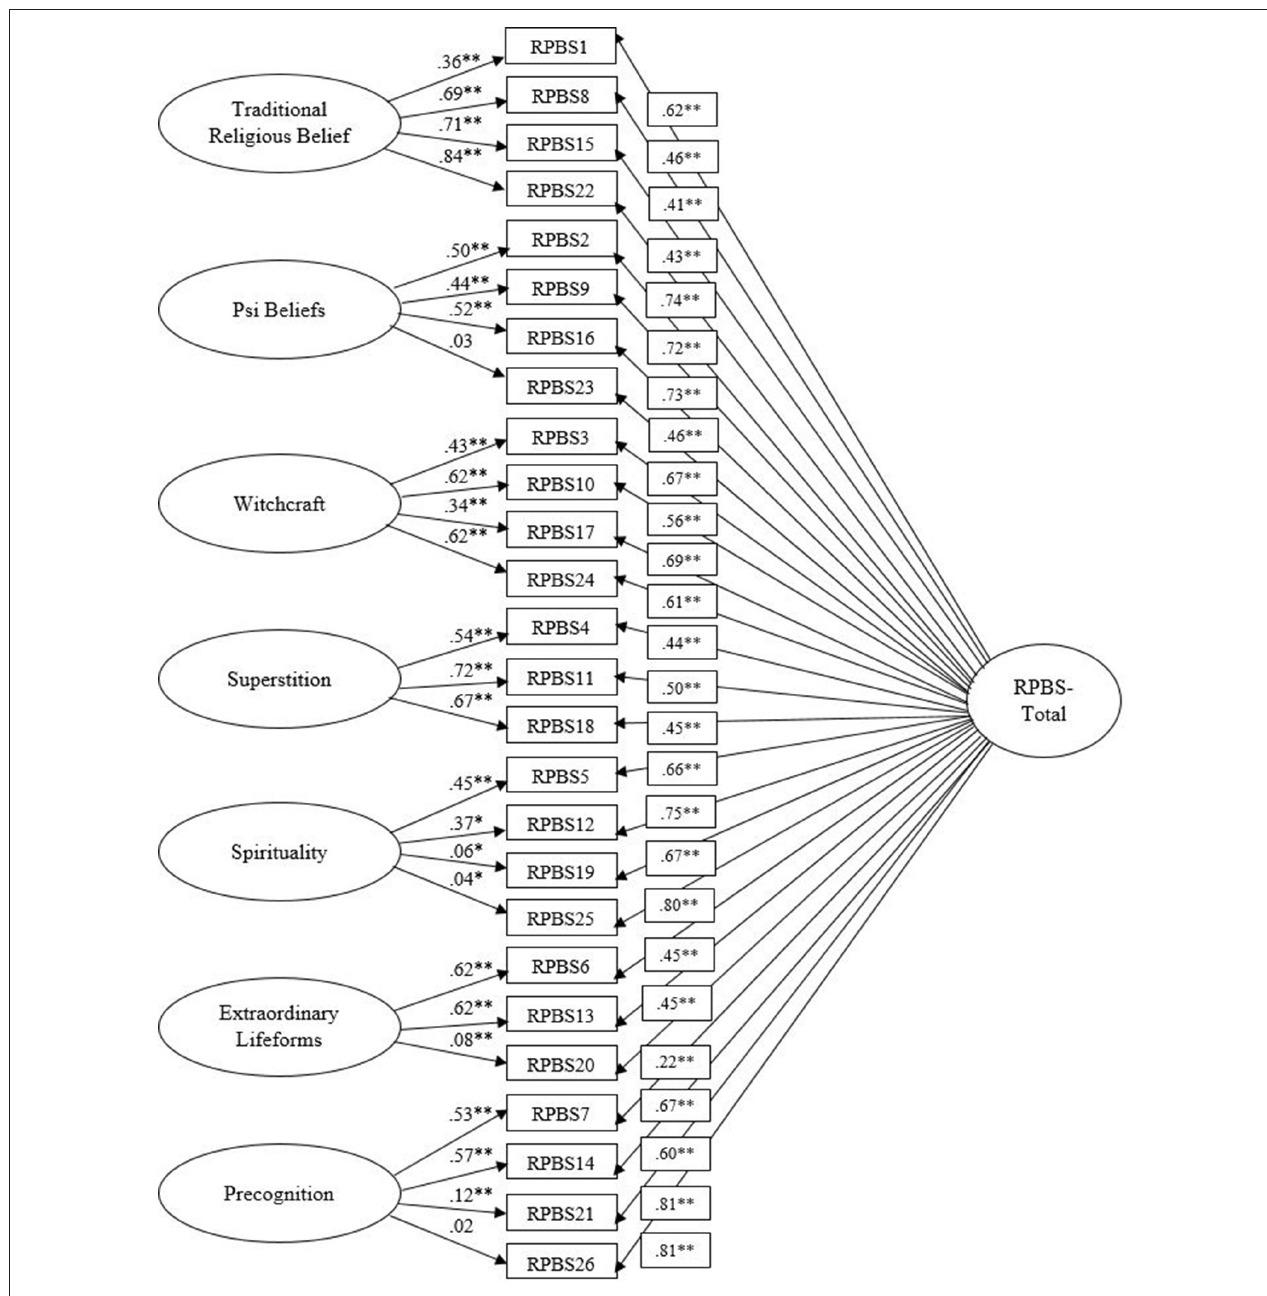
FIGURE 1 | Seven-factor bifactor RPBS model. Latent variables are represented by ellipses; measured variables are represented by rectangles; error is not shown, but was specified for all variables. Error covariances between RPBS1 and RPBS15, RPBS3 and RPBS17, RPBS21 and RPBS26 are not shown but were included in the analysis. * p < 0.05; ** p <